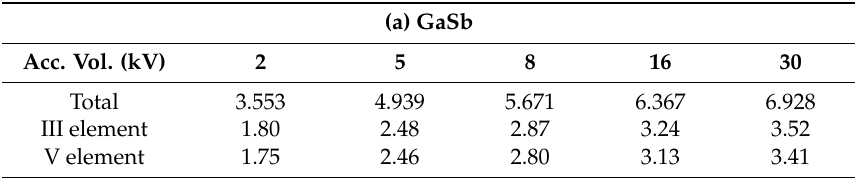
Figure 4. Surface SEM images of Ge irradiated with a Ga + ion beam at room temperature ( left ). The accelerating voltages used were 2, 5, 8, 16, and 30 kV at a scanning dose of 5 × 10 18 ions/m 2 per scan. The total number of vacancies created on Ge was estimated using the ion dose (ions/m 2 ) multiplied by the vacancy count (/ion) as calculated by SRIM simulations, as a function of accelerating voltage ( right ). Table 2. Sputtering yield (atoms/ion) calculated by SRIM simulations [37] in ( a ) GaSb, ( b ) InSb, and ( c )